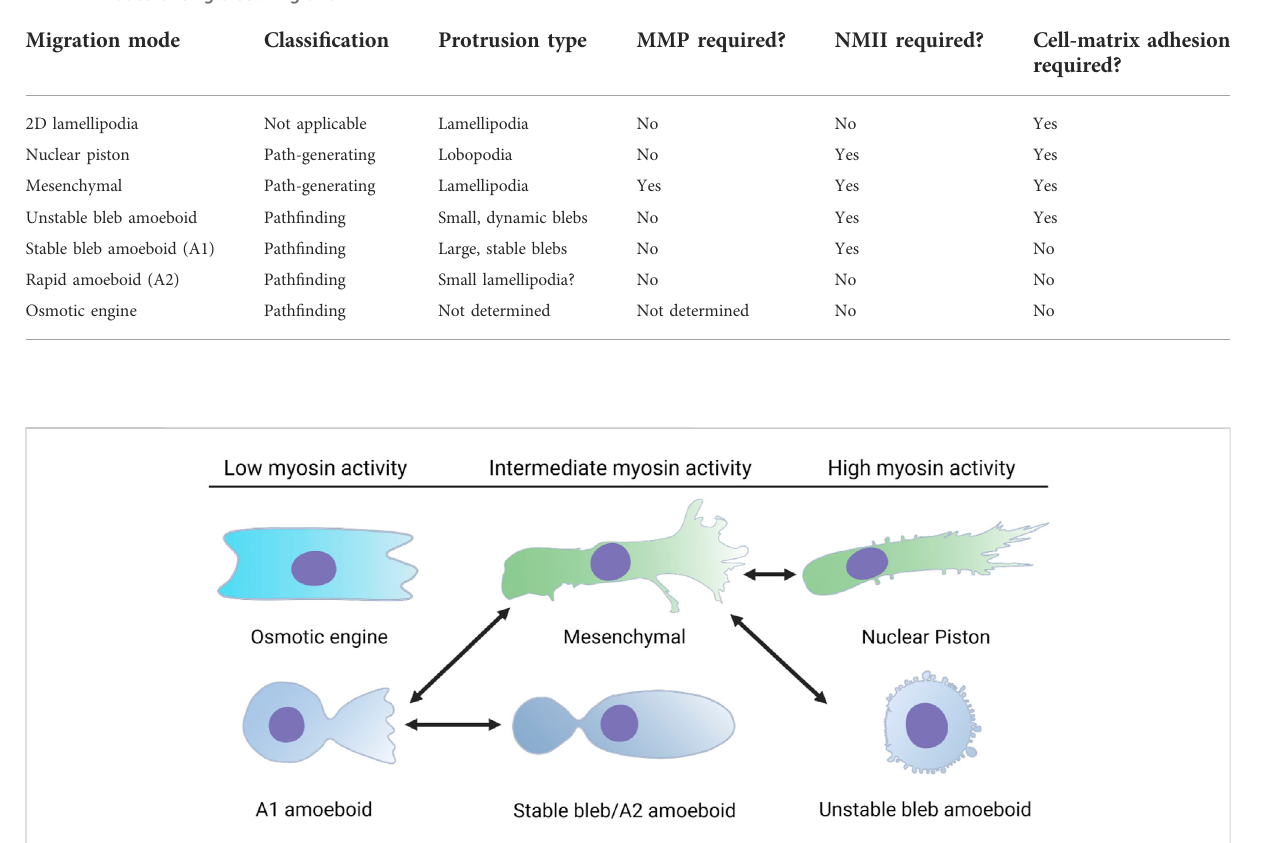
FIGURE 1 Single cells can switch between distinct modes of 3D cell movement. Each of these modes of migration have different requirements for cell- matrixadhesionandactomyosin contractility.Cellsusing theosmoticengine orstable blebmodes ofmovementrelyonfriction against thesurfaces that con fi ne them to achieve forward movement. Cells using the unstable bleb amoeboid, 3D mesenchymal (lamellipodia-based), or nuclear piston (lobopodia-based) modes rely on cell-matrix adhesions to propel themselves forward. The double headed arrows indicate the